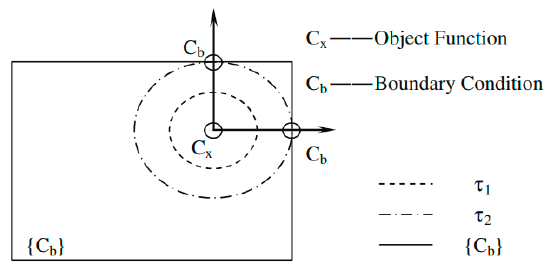
Figure 2. Removal influence graph (RG).